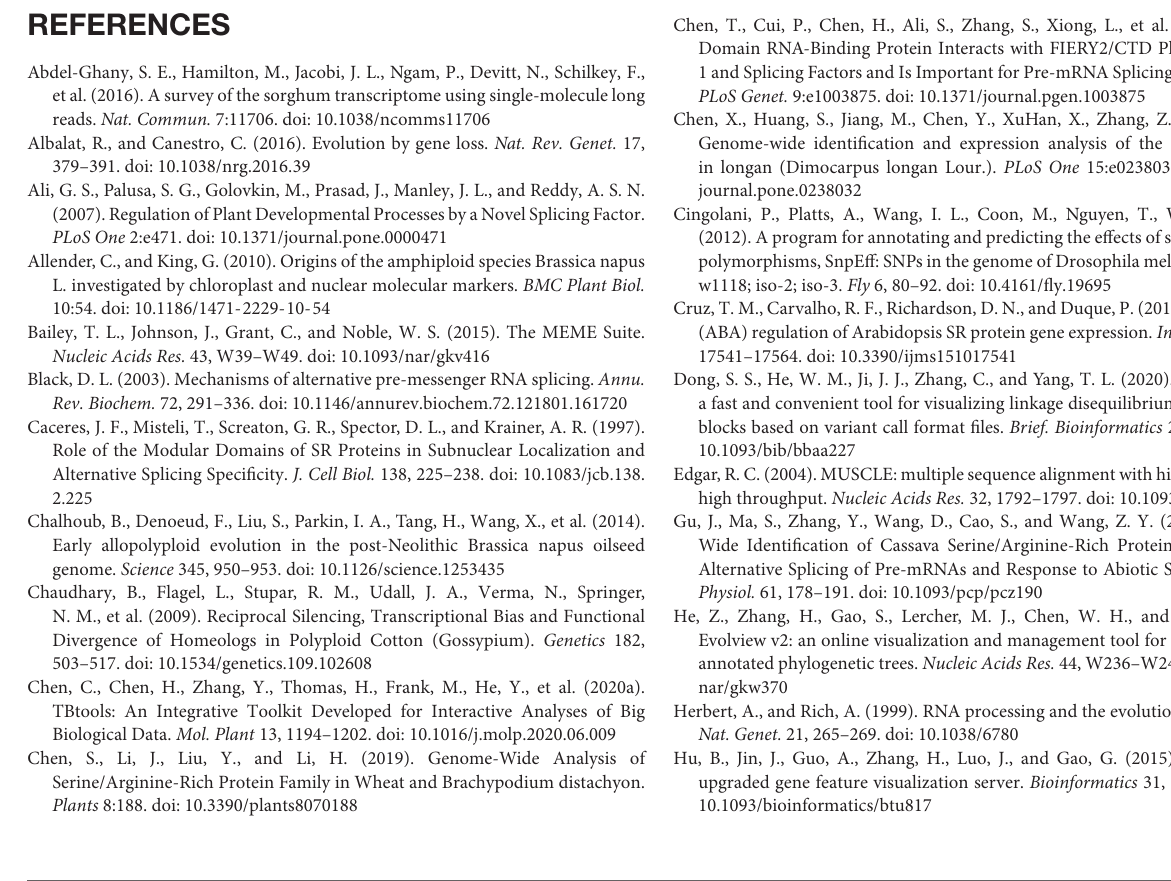
Supplementary Figure 1 | Amount of cis -acting regulatory elements in promoters of SR genes in B. napus . Elements numbers were processed with log 2 normalization. The color scale represented amounts from low (blue color) to high (red color). Supplementary Figure 2 | The alignment information of BnaA04g03560D and BnaC04g25450D. Supplementary Figure 3 | Heatmap representation of transcripts of SR genes in different tissues. Expression data were processed with log 2 normalization. The color scale represented relative expression levels from low (blue color) to high (red color). Supplementary Figure 4 | Splicing profiles of SR genes in B. napus under abiotic stress condition. (A) Distribution of genes that produced one or more transcripts from RNA-Seq data. (B) Classification of AS events from RNA-Seq data. IR, intron retention; A3SS, alternative 3 (cid:48) splice site; A5SS, alternative 5 (cid:48) splice site; ES, exon skipping. (C) Five transcripts were obviously induced by all four stresses. Expression data were processed with log 2 normalization. The color scale represented relative expression levels from low (blue color) to high (red color). Supplementary Figure 5 | Association mapping analysis of SR genes in 324 core collections of B. napus germplasm. (A,B) BnaA03g12870D was significantly associated with primary flowering time. (C,D) BnaA03g12870D was significantly associated with branch number. (E,F) BnaC03g20680D was significantly associated with the flowering